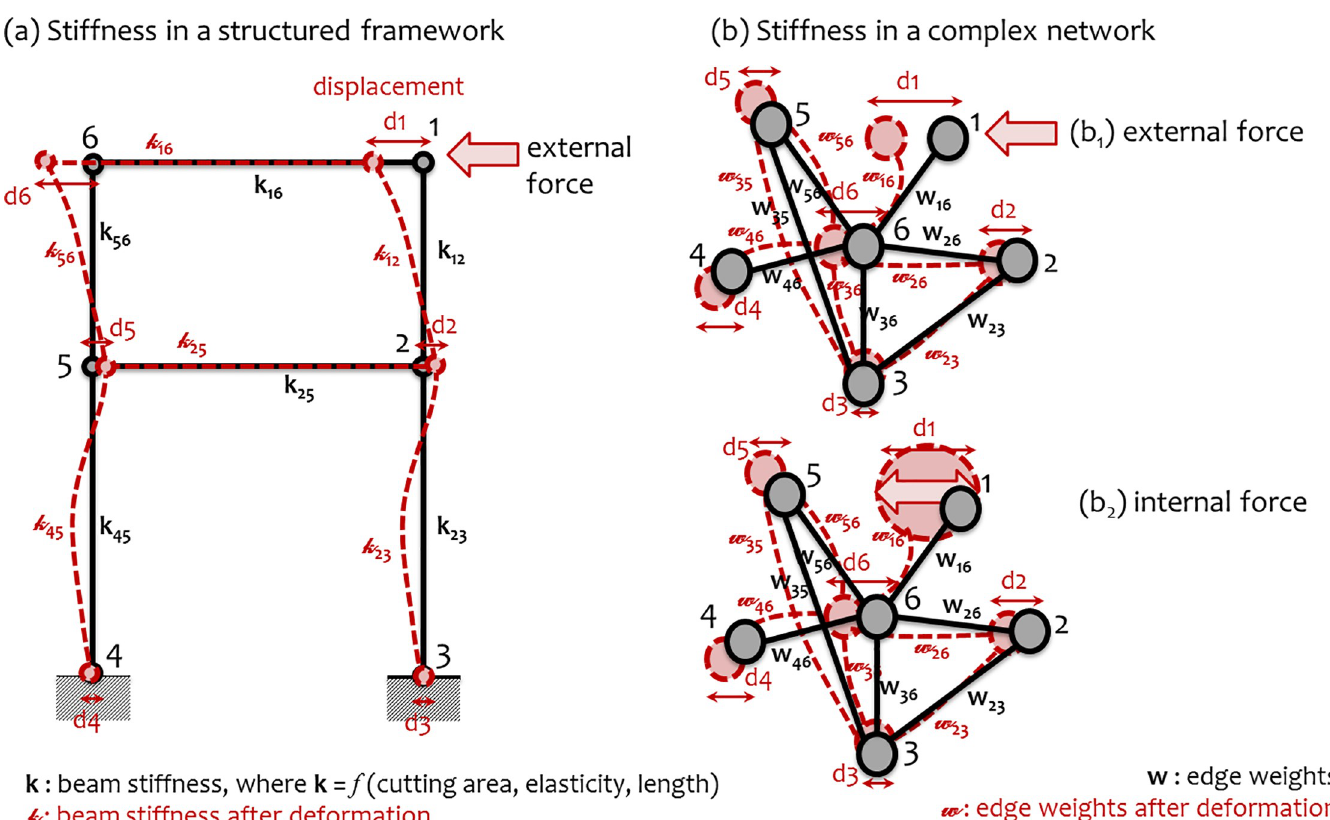
Fig 1. Semantic diagram for the conceptual analogy of stiffness, from the structural engineering to complex networks: (a) in structural engineering, stiffness describes the ability of a structured framework to resist against an external force, whereas (b) in complex networks, stiffness represents the network’s ability to resist against (b 1 ) external or (b 2 ) internal causes (forces) applied to network nodes inducing changes in the